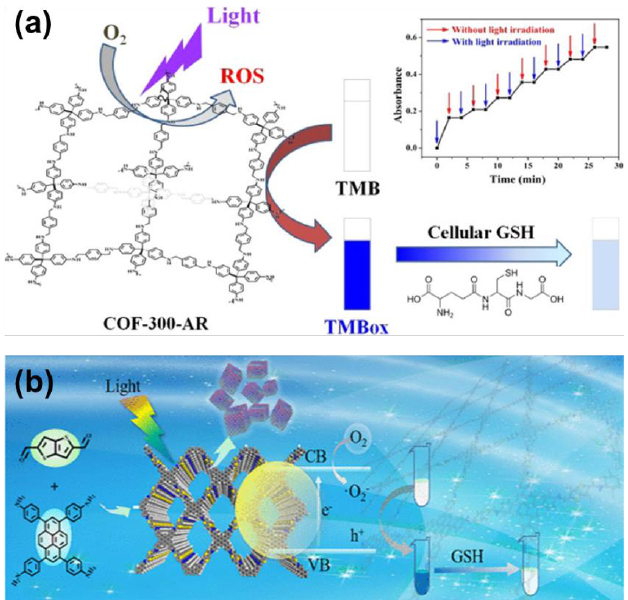
Figure 13. ( a ) Immunosensor for cTnI Detection based on TB − Au − COFs − Ab 2 [165]. Copyright 2018 Figure 12. ( a ) COF−300−AR for GSH detection [26]. Copyright 2020 American Chemical Society; ( b ) Py−TT COF for GSH sensing [27]. Copyright 2021 American Chemical Society. Elsevier B.V; ( b ) Immunosensor for cTnI Detection based on HRP − Ab2 − Au − COF [166]. Copyright 2021 American Chemical